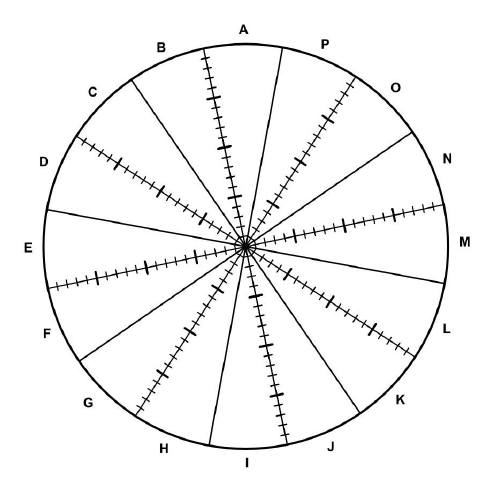
Figure 4: The Game Grid Overlay (shown larger in Appendix C) For the benefit of those not familiar with the You And Him Fight; IOTHY – I'm Only Trying To Help You; SWYMMD is See What You Made Me Do; LHHIT - Look How Hard I